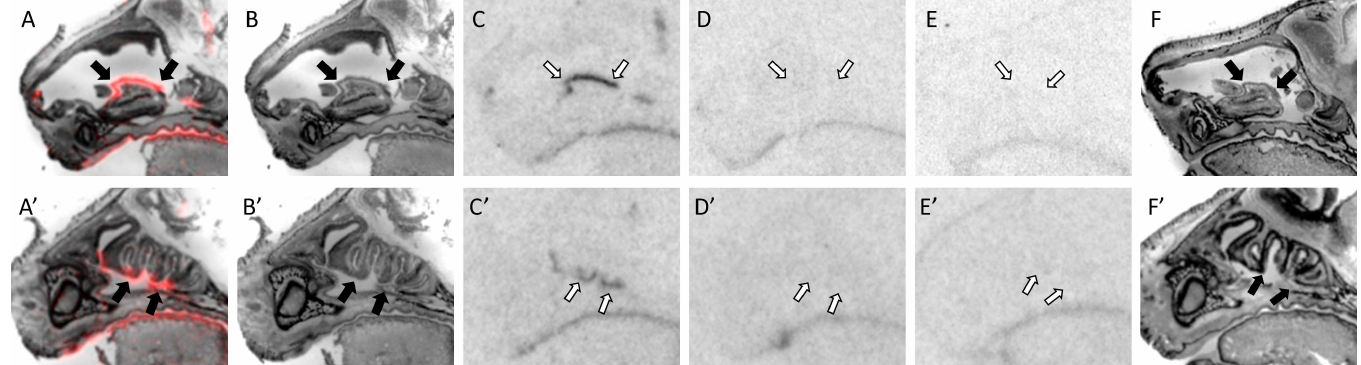
Fig 9. OXTR ligand binding in the vomeronasal organ (A-F) and olfactory epithelium (A’-F’) of P0 mice. Pseudo-color composite (OXTR in red, cresyl violet counterstain in gray) (A, A’), followedby cresyl violet counterstain (B, B’), with black arrows indicating regionof interest. OXTR ligandbindingis indicatedby white arrows in the 0 nM OXT competition(C, C’), followedby 1000 nM OXT competingwith OVTA radioligandto reduce the signal (D, D’). OXTR ligandbindingwas not present in OXTR KO mice (E, E’), followedby the post-processed cresyl violet tissue of the OXTR KO (F,